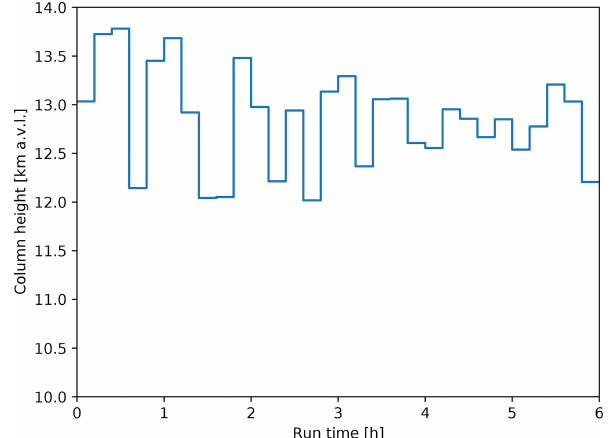
Figure 4. Time evolution of the eruption column height used to define the twin experiment true state. The 6h duration eruption is characterised by multiple eruptive phases with a duration of 20min and column height randomly sampled within the range 12–14km above the